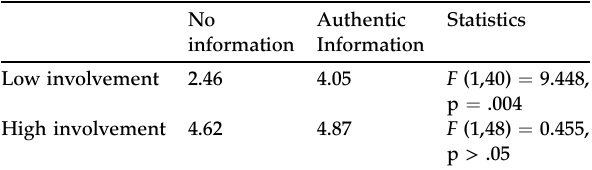
Table 1. Con fi dence as a function of back label information and